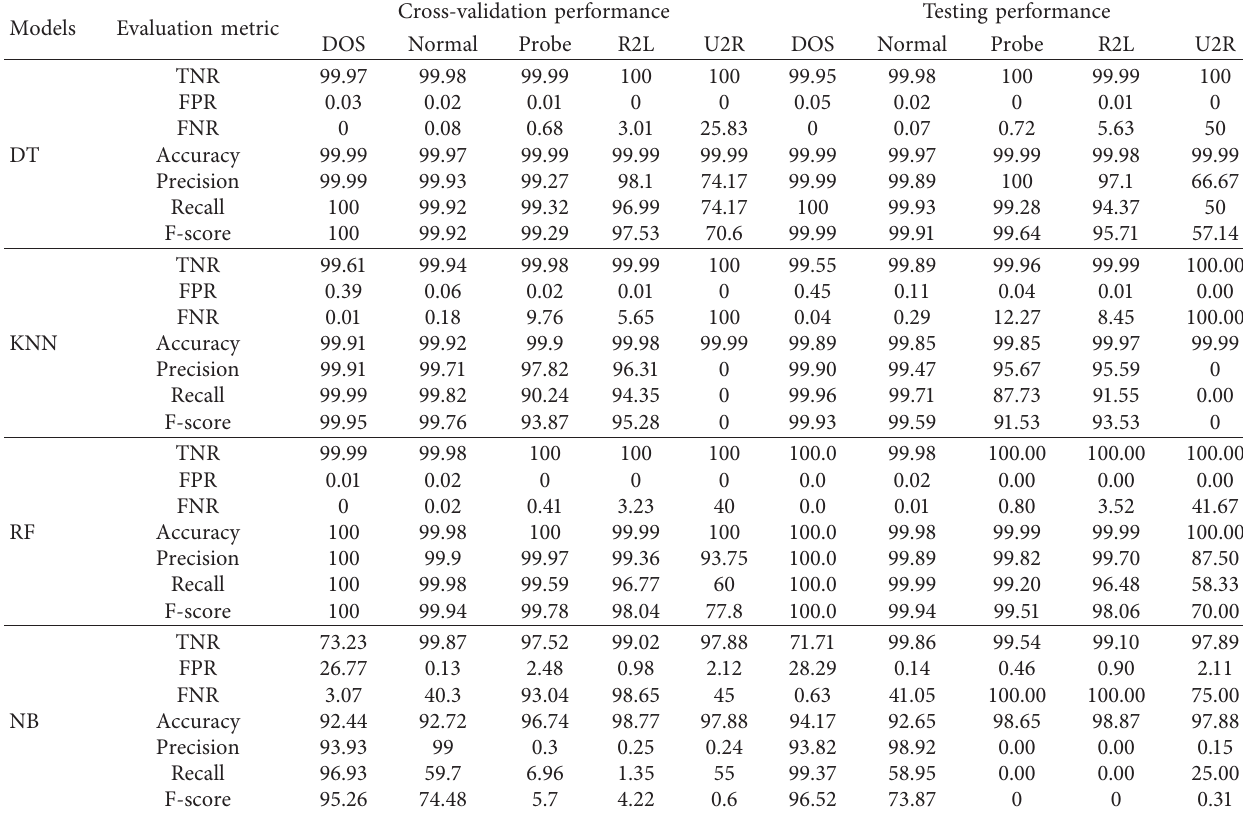
Table 14: The performance of machine learning for KDD dataset using all features.